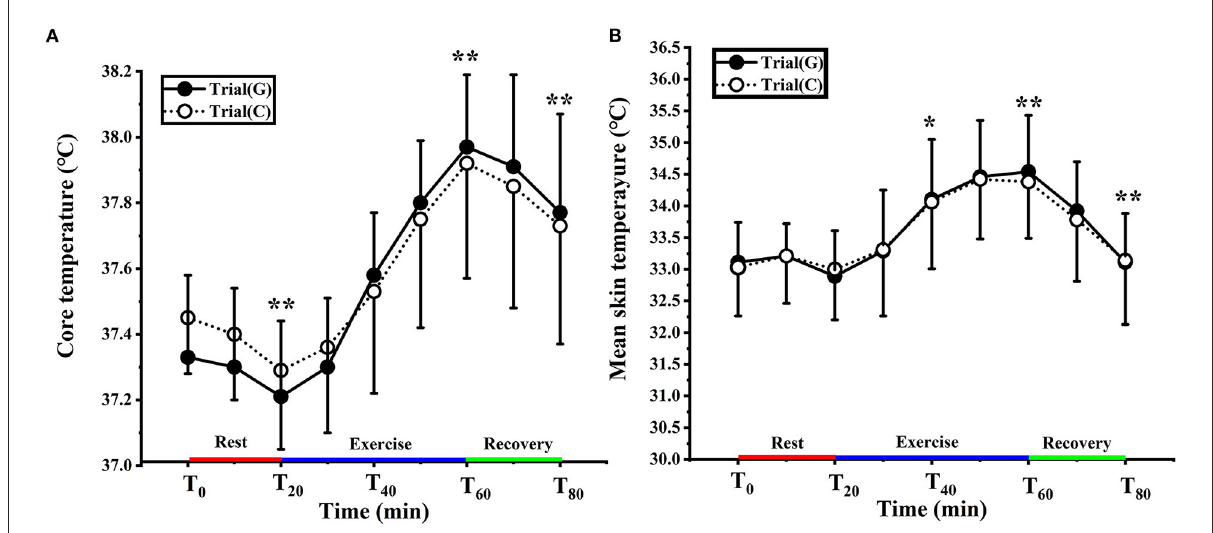
FIGURE3 Change in core (A) and mean skin (B) temperature in trial G (black) and trial C (white). Values are means ± SD. Bars represent standard deviations. * P < 0.05, ** P < 0.01, significant difference compared to T 0